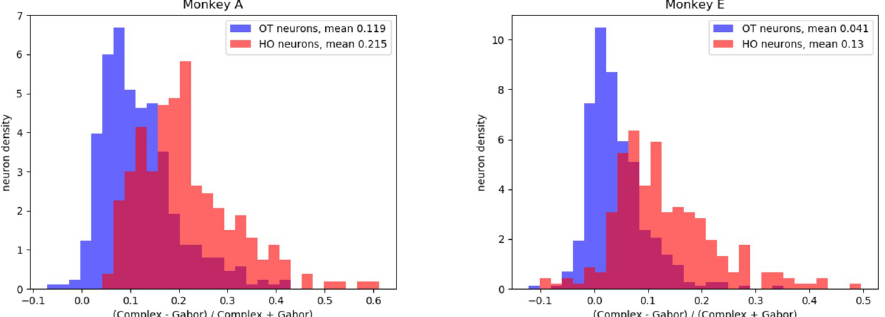
Fig 10. Distributions of HO and OT neurons’ scores. These figures show histograms of the HO and OT neurons’ scores, measured by the difference in performance between the sparse FKCNN and Gabor models, for each monkey. Note that since the classes have different numbers of neurons, the histograms have been normalized by the total number of neurons in each group. The two cell types are fairly separable by this metric, with a linear separability of 73% for Monkey A and 75% for Monkey E, compared to baselines of 62% and 61%